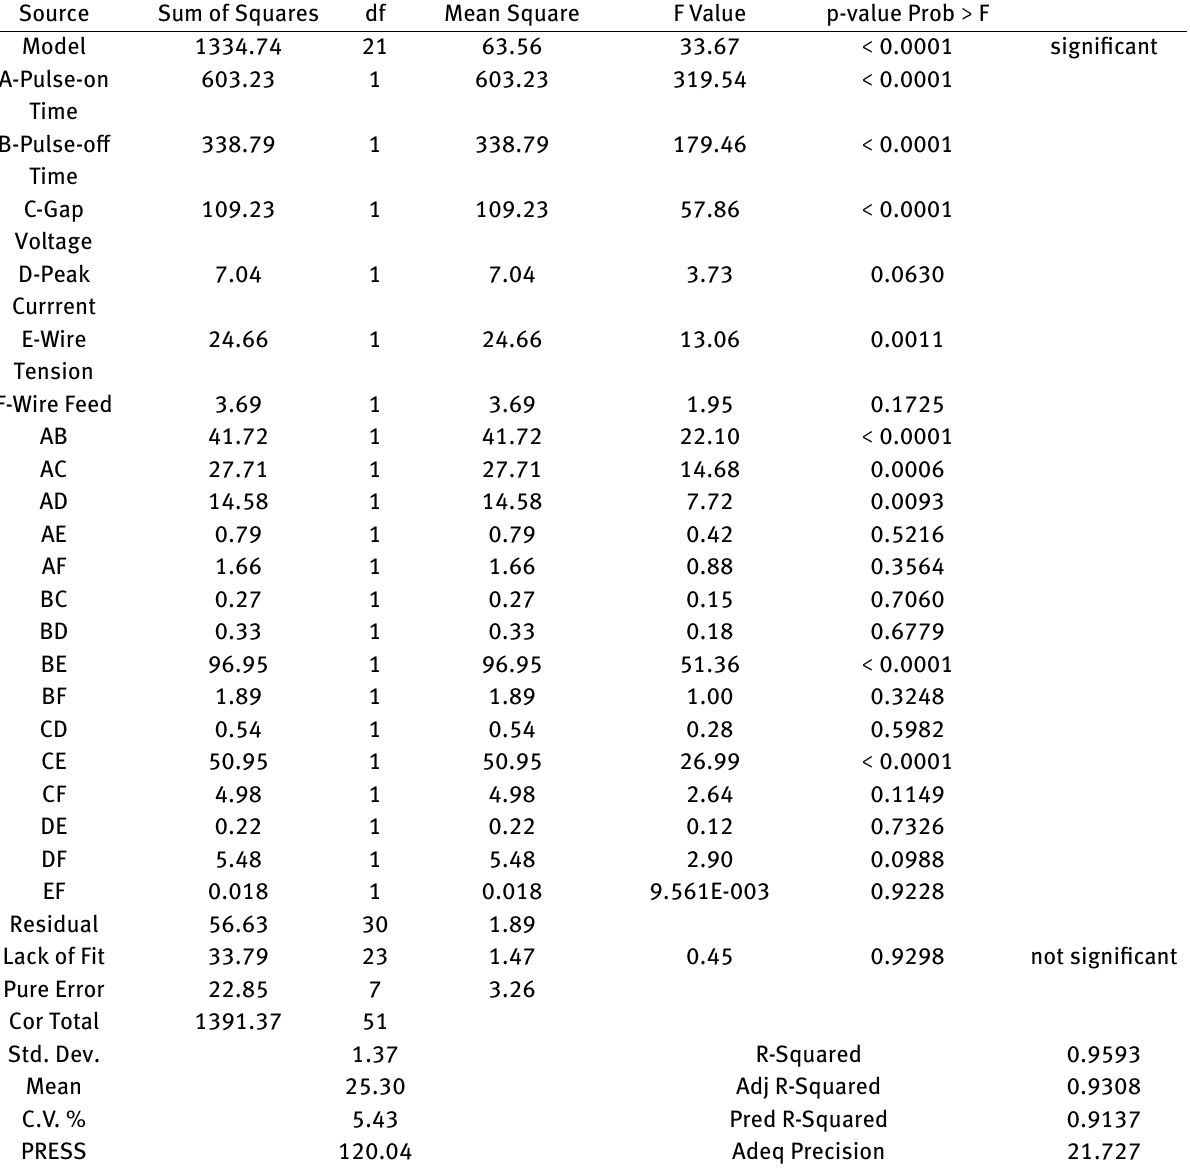
Table 4: Analysis of variance (ANOVA) for response MRR